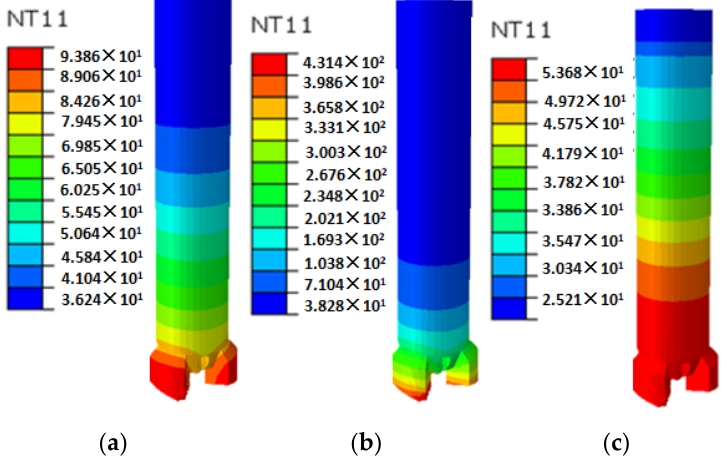
Figure 16. Temperature nephogram of the core bit and core tube at the core depth of 100 m in GHS: ( a ) the end of first stage; ( b ) the end of second stage; and ( c ) the end of third